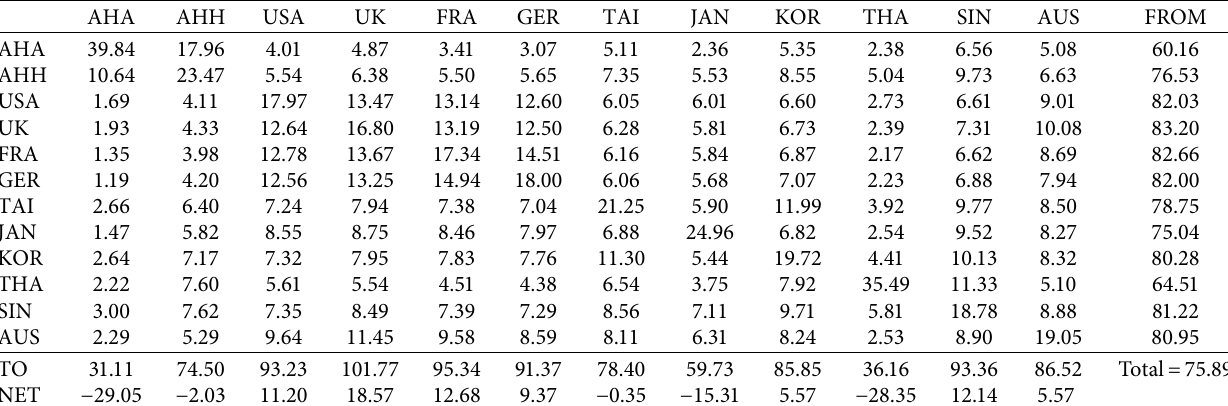
Table 3: Preperiod sample return spillover table.